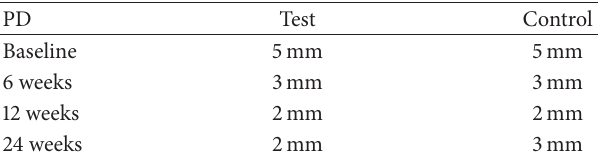
Table 1: Probing depth average values in test and control group after